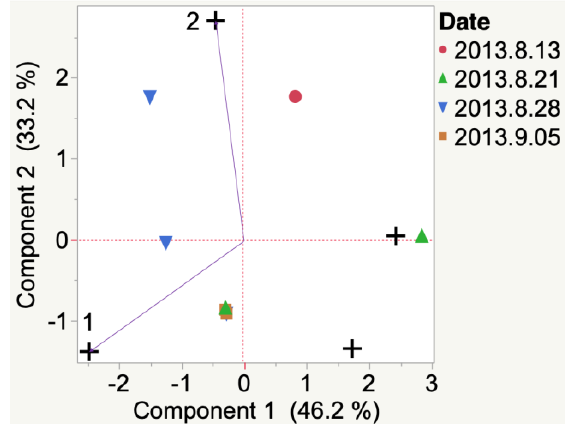
Figure 5. Evolution of VOCs emitted from single berry from veraison to harvest of 2013 Frontenac grapes grown in South Dakota. Key to most representative volatiles from HCA, shown as vectors from the origin and read clockwise: 1 = Palmitic acid, 2 = Acetic acid.